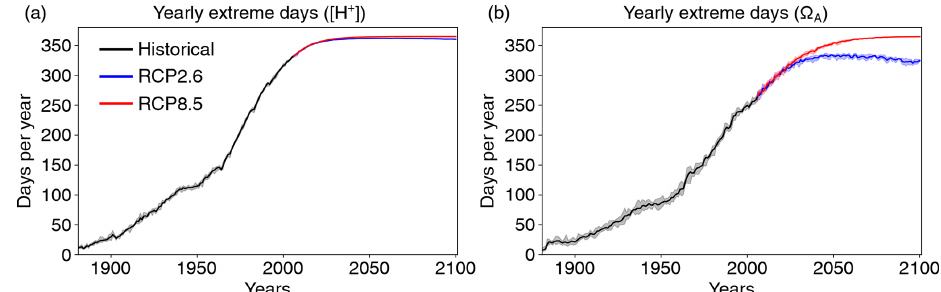
Figure 4. Simulated globally averaged yearly extreme days defined with respect to a fixed baseline for [H + ] using the preindustrial 99th percentile (a) and for (cid:127) A using the preindustrial 1st percentile (b) . Shown are changes at the surface over the 1881–2100 period following historical (black lines) and future scenarios, RCP8.5 (red) and RCP2.6 (blue). The thick lines display the five-member ensemble means, and the shaded areas represent the maximum and minimum ranges of the individual ensemble